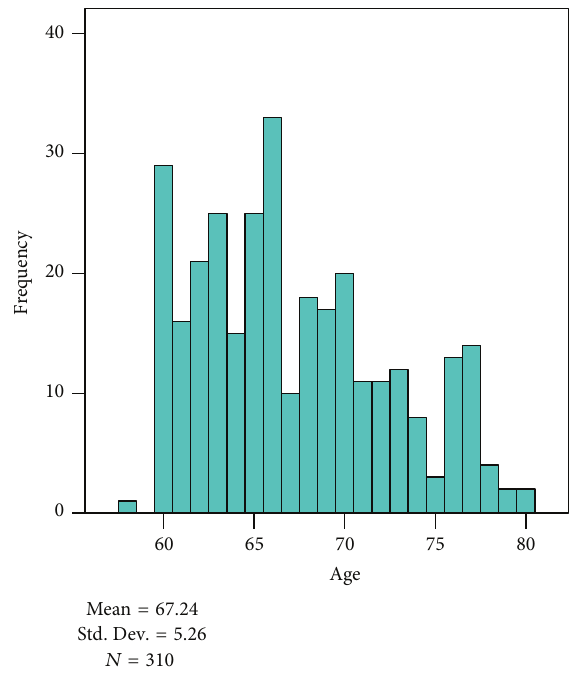
Figure 1: Age distribution of older adults who participated in the